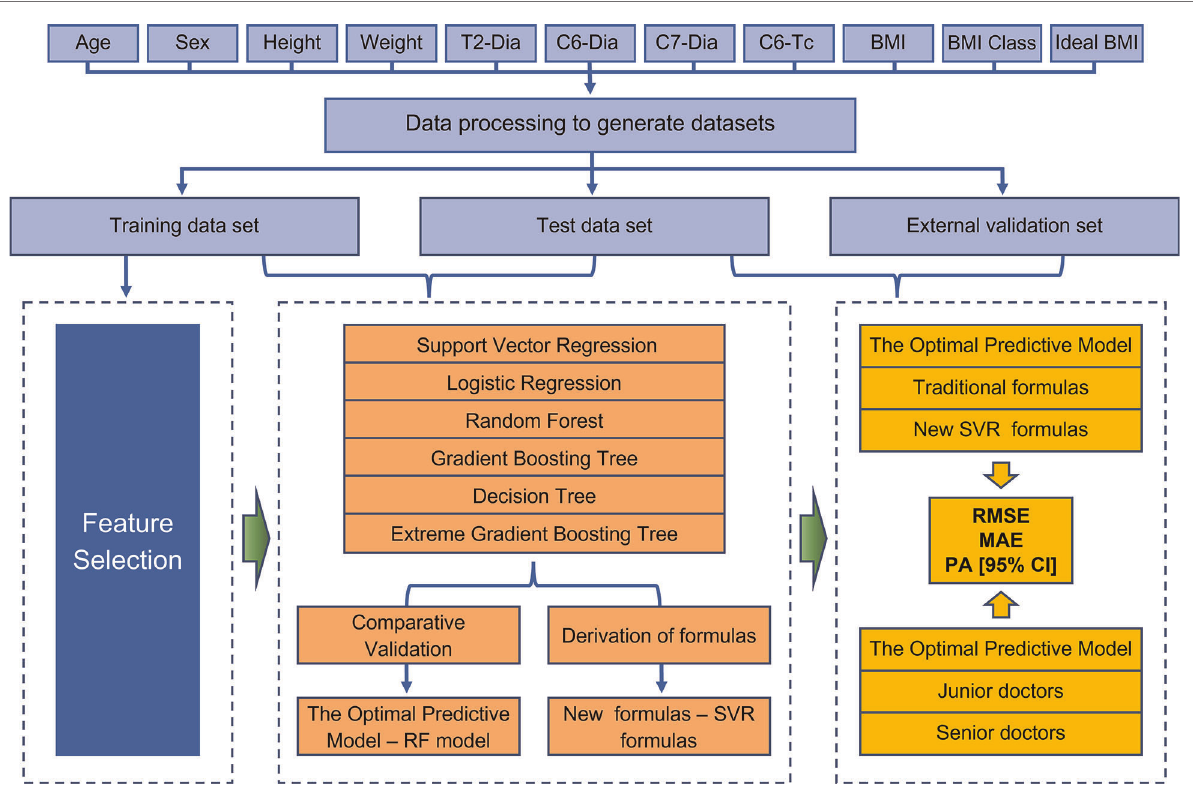
FIGURE 1 Detailed fl ow chart of the entire study. Patients with valid information were used as the total data set, and the data were processed to further derive training, test, and external validation sets. Feature selection was then performed, and six machine models were developed and validated to obtain the optimal predictive models, while new SVR formulas were derived to interpret the meaning of existing clinical formulas and they guide clinical decisions. Finally, the performance of the models was evaluated by assessing the metrics (RMSE, MAE and the prediction accuracy) when compared with both traditional formulas and